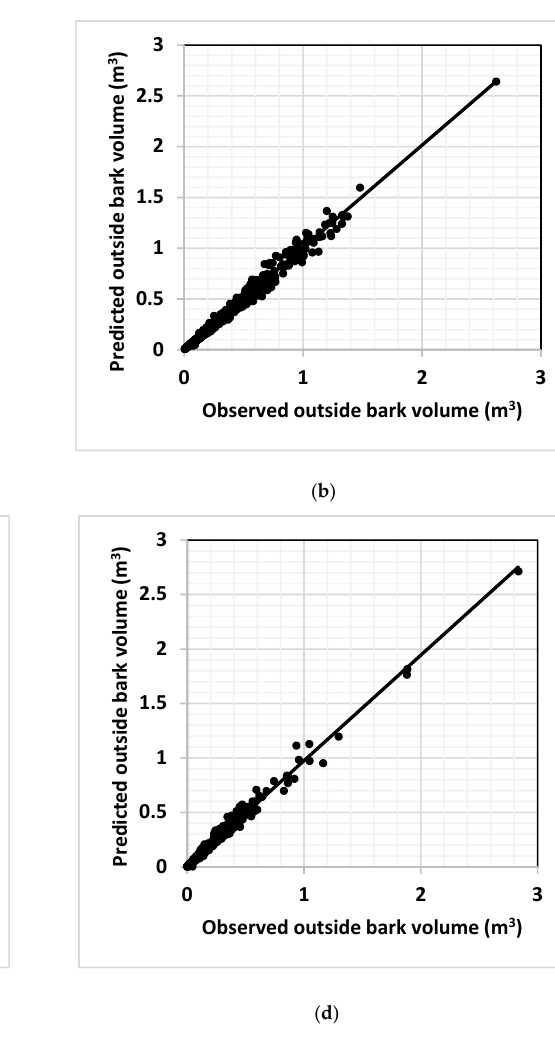
Figure 2. Predicted inside bark volumes plotted against observed volumes for ( a ) jack pine, ( b ) black spruce, ( c ) balsam fir, and ( d ) sugar maple trees. The solid line represents the 1:1 line for these tree species.